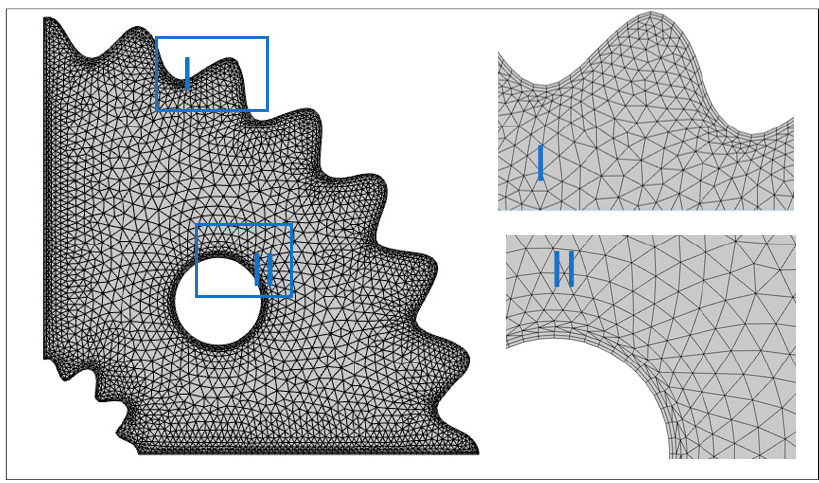
Figure 3 A computational grid at finer-level mesh. Figure 3. A computational grid at finer-level